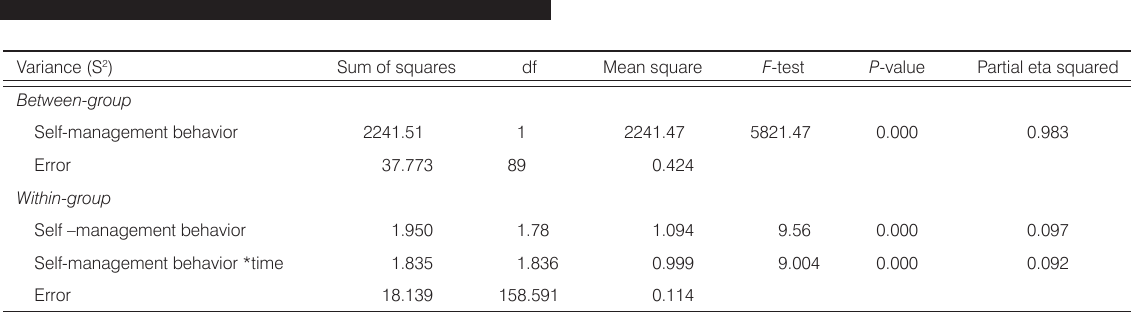
Table 5. Comparison of mean differences of self-management behaviors before – after program participation (at week 4, at week 13).